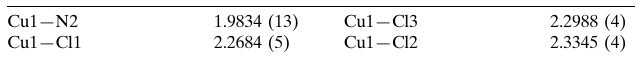
Selected bond lengths (A˚ ).